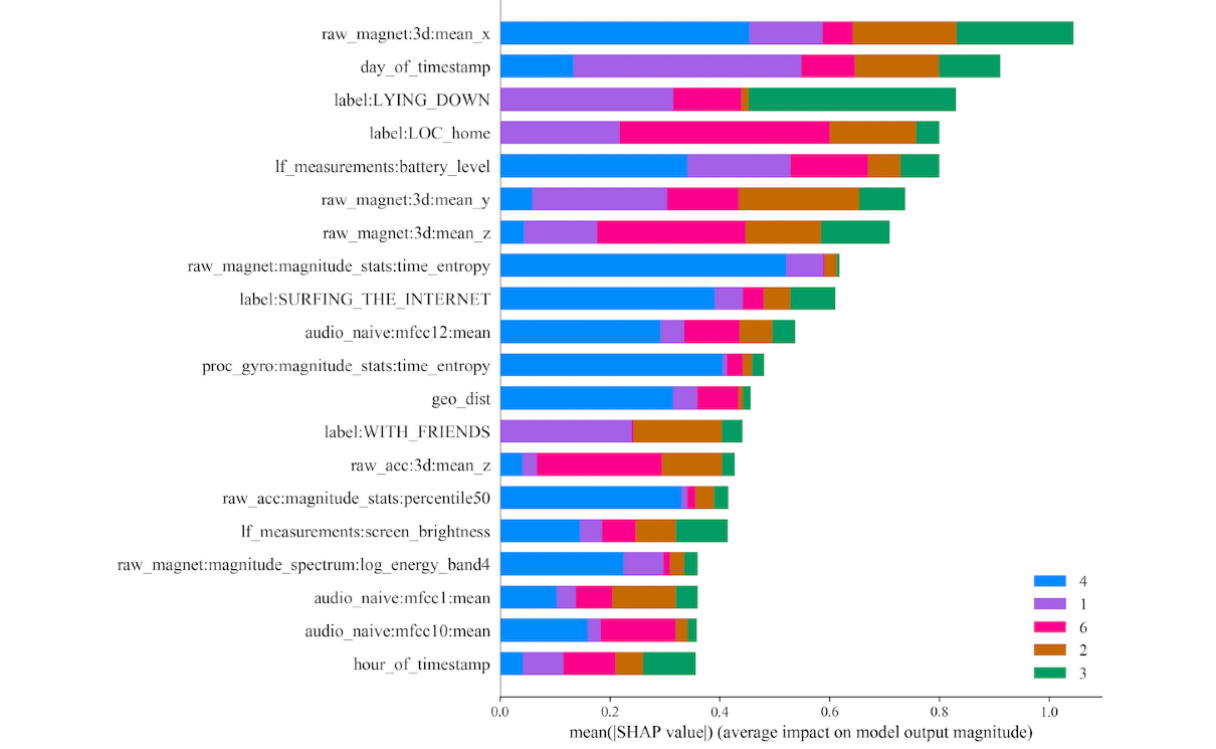
Figure 4. Feature importance for emotional state detection of the general model obtained using XGBoost and shapley additive explanation. The color-coded portions represent the contribution of the corresponding feature to detect different states (classes) of emotions: 1, discordant; 2, pleased; 3, dissuaded; 4, aroused; 5, submissive; and 6, dominant. SHAP: SHapley Additive